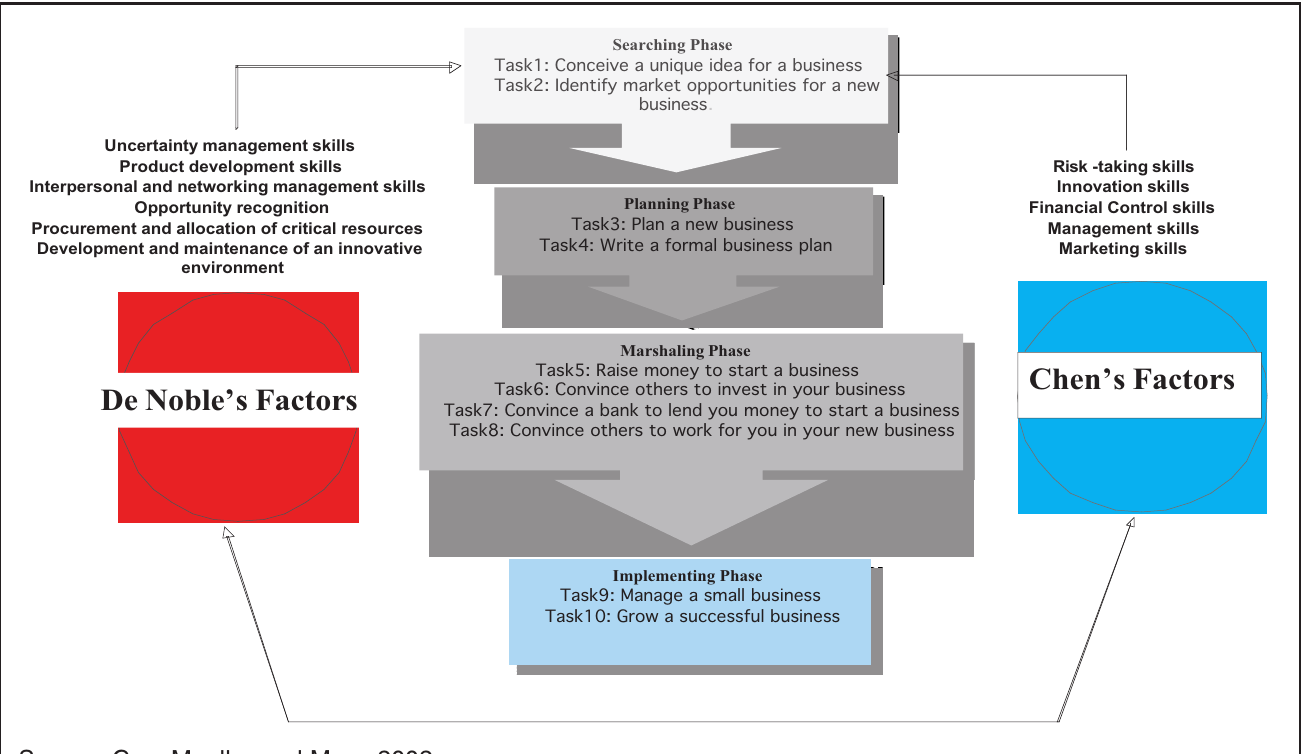
Figure 1. Relationship of Self-Efficacy to Tasks and Roles Identified within the Entrepreneurial